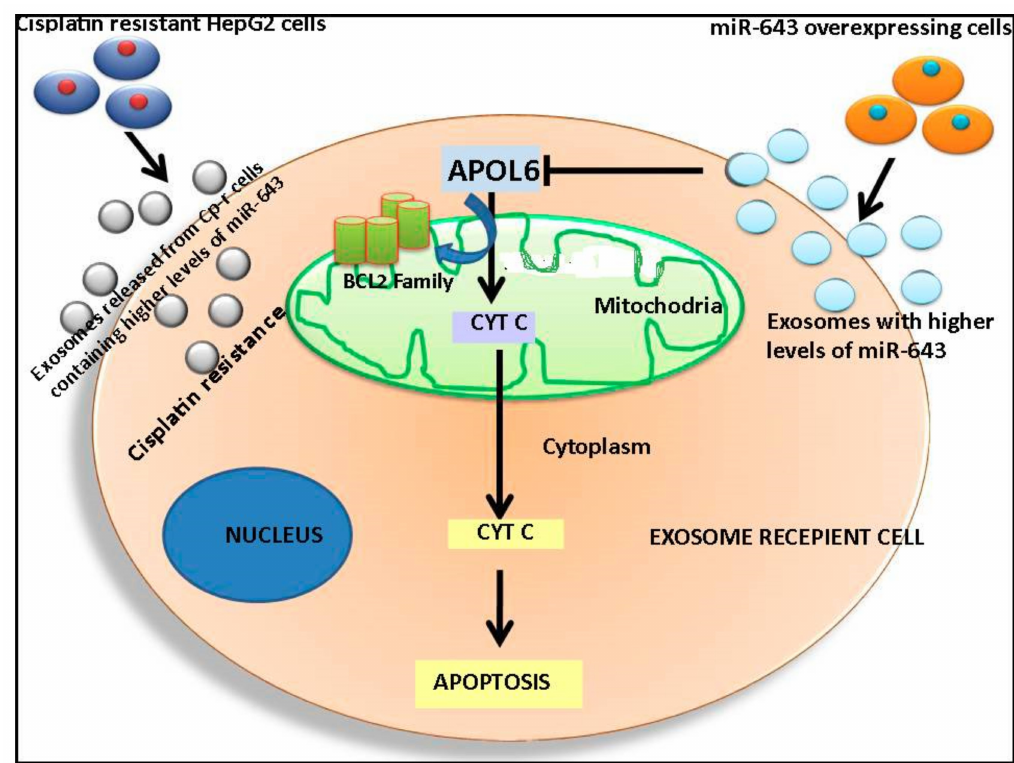
Figure 12. Schematic representation of mechanism of cisplatin resistance conferred by horizontal transfer of miR-643. Exosomes released from Cp-r HepG2 cells containing higher levels of miR-643 make the recipient Hela cells resistant to cisplatin. APOL6 is a major target of miR-643 and plays an important role in mitochondrial apoptosis [45]. Exosomes containing higher levels of miR-643 can target APOL6 and reverse APOL6 mediated apoptosis, thus promoting cell survival.